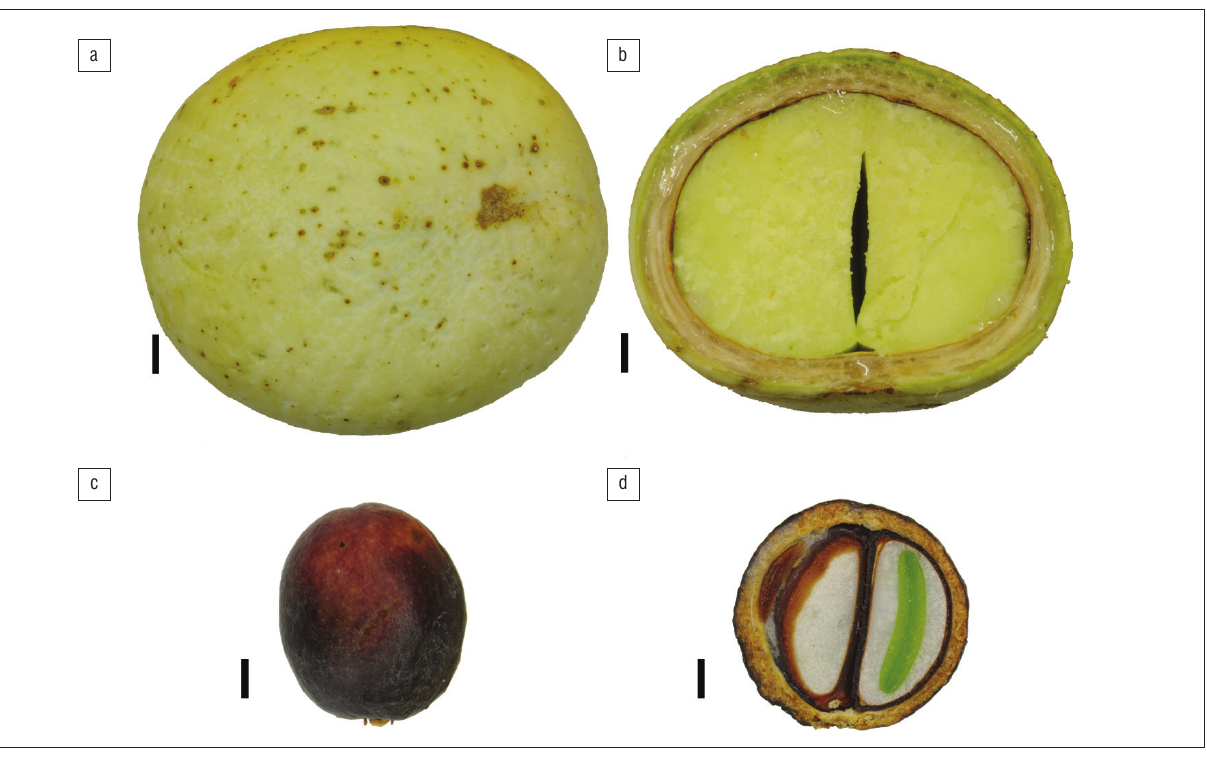
Figure 1: Intact and cross-sectioned fruits of (a,b) Heeria argentea and (c,d) Hartogiella schinoides , showing the thin, fleshy pericarps and chlorophyllous